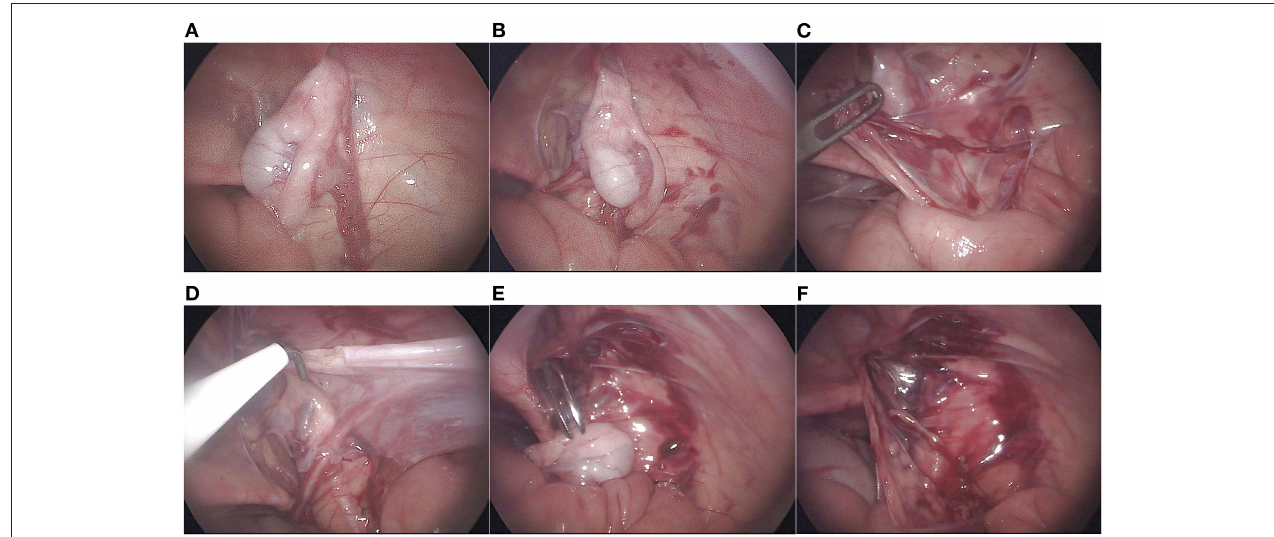
FIGURE 1 | Surgical procedure. (A) the position of the testis and whether the internal inguinal ring is patented were observed; (B) incision of the peritoneum lateral to the spermatic vessels and medial to the vas deferens; (C) Mobilization of spermatic vessels proximally; (D) gubernaculum was transected; (E) Establishment and expansion of the medial channel of the inferior epigastric vessels; (F) Descending testis under laparoscopic direct vision.